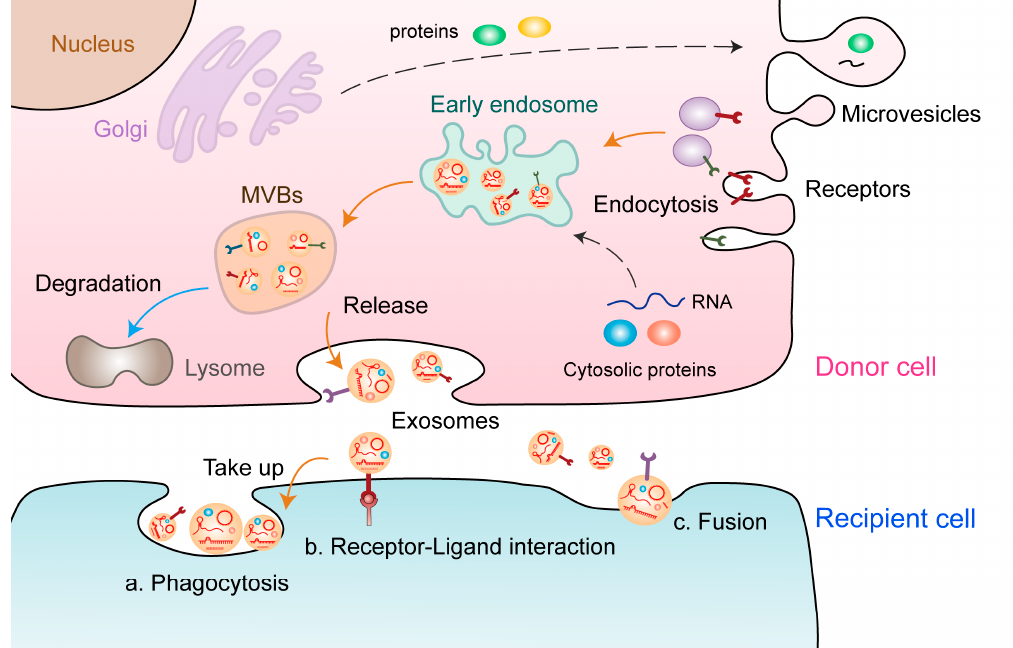
Figure 1. Formation and release of EVs. The formation of EVs involves the following processes: Proteins are transported from the Golgi apparatus or internalised from the cell surface, and nucleic acids are endocytosed and transferred to early endosomes. Early endosomes gradually mature into late endosomes and MVBs, some of which are degraded, whereas others are secreted as exosomes. These exosomes carry multiple biological components, including proteins, lipids, and nucleic acids (e.g., ncRNAs), which are delivered to the recipient cell through different ways: (a) phagocytosis, (b) receptor–ligand interaction, and (c) direct fusion.